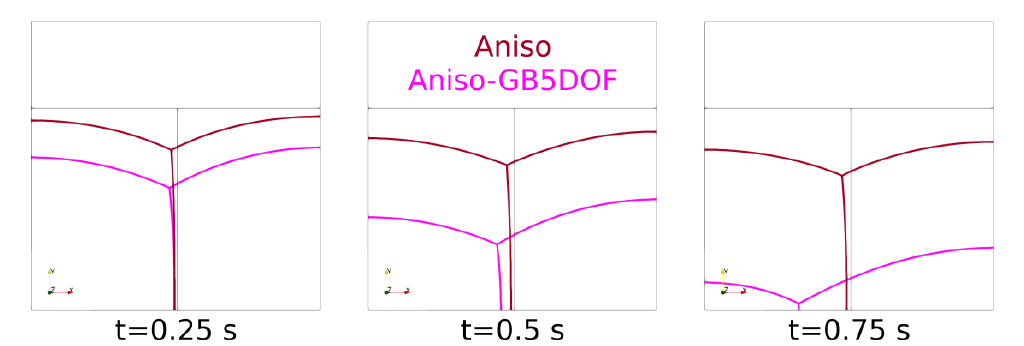
Figure 21. Interface evolution for three different times, t = 0.25, 0.5, 0.75 s.